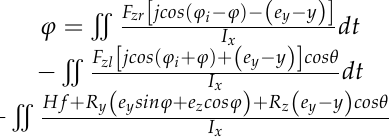
Table 1. Specifications of the vehicles.